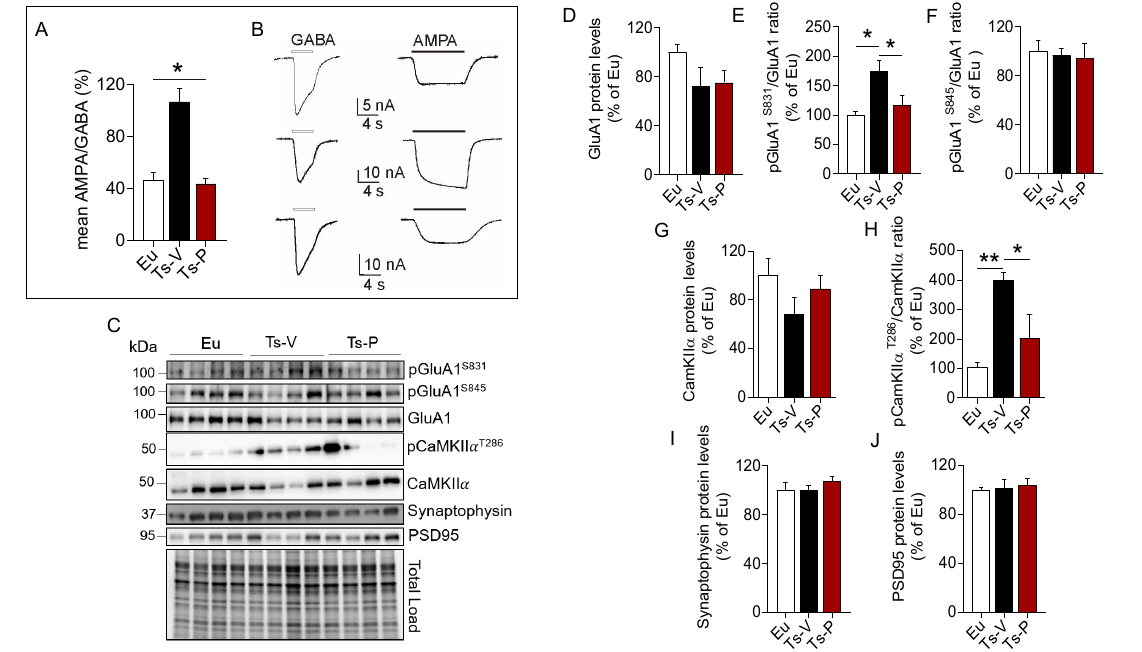
Figure 5. Improved synaptic plasticity mechanisms following KYCCSRK intranasal administration in Ts2Cje mice. AMPA and GABA currents in oocytes transplanted with cortical membranes along with proteins regulating synaptic plasticity mechanisms were evaluated in Eu and Ts2Cje (Ts-V) mice treated with vehicle (saline) and Ts2Cje (Ts-P) mice treated with KYCCSRK peptide (0.5 mM) for two weeks (n = 4/group). ( A ) Bars represent the mean ± SEM of the ratio between I AMPA and I GABA (reported as percentage) in Eu (oocytes n = 12), Ts-V (oocytes n = 20) and Ts-P (oocytes n = 13) mice, as shown. GABA 500 µ M was applied for 4 s, while AMPA 20 µ M plus CTZ were applied for 10 s. Holding potential was − 60 mV and * shows statistical significance (Kruskal–Wallis One Way Analysis of Variance on Ranks with Dunn’s test, p < 0.05). The mean of I AMPA was 7.2 ± 0.9 nA, 34.9 ± 3.9 nA, 11.4 ± 2.4 nA in Eu, Ts-V and Ts-P, respectively. The mean of I GABA was 16.7 ± 2.3 nA, 35.3 ± 3.7 nA, 25.9 ± 4.8 in Eu, Ts-V and Ts-P, respectively. Note the similar values in Eu and Ts-P. ( B ) Representative current traces recorded in oocytes of the experiments shown in ( A ) as indicated; white bars, GABA evoked-currents; black bars, AMPA evoked-currents. ( C ) Representative Western blot and total load images and densitometric evaluation of ( D ) GluA1 total protein levels, ( E , F ) GluA1 phosphorylation at S831 and S845 (reported as pGluA1 S831 /GluA1 and pGluA1 S845 /GluA1 ratio); ( G , H ) CamKII α protein levels and activation (evaluated as pCamKII α T286 /CamKII α ratio); ( I ) synaptophysin and ( J ) PSD95 protein levels. All densitometric values were normalized per total protein load and are given as a percentage of Eu set as 100%. Data are shown as mean ± SEM. One-way ANOVA with Dunnett test: * p < 0.05 and ** p <